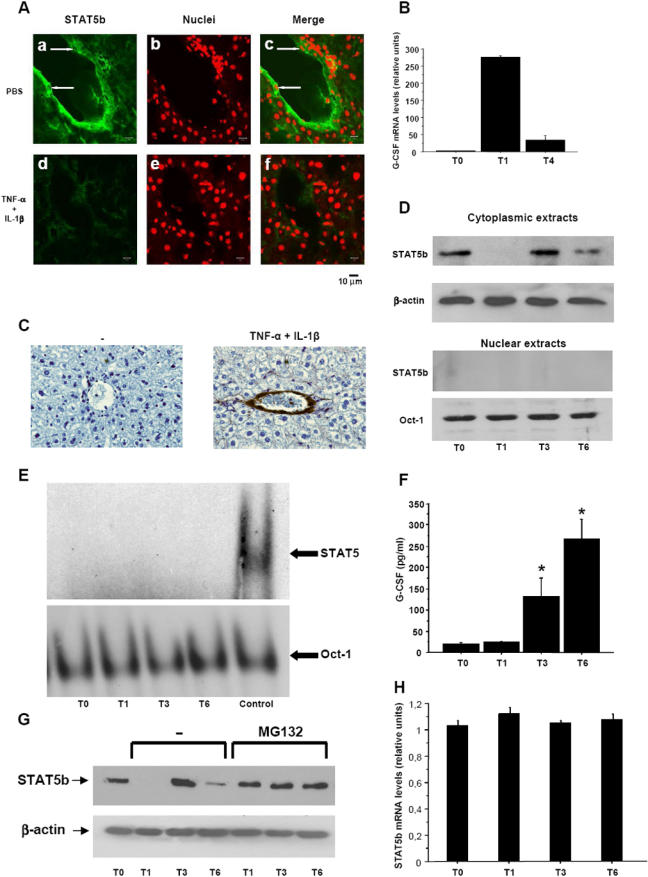
Degradation of cytoplasmic STAT5b in WT LECs following inflammatory stimulation, and subsequent enhancement of G-CSF production.(A) Wild-type mice were injected intravenously with PBS or with 2 µg recombinant murine TNF-α and 2 µg recombinant murine IL-1β. Livers were harvested 30 min later, and liver sections were analyzed for STAT5b expression and localization by immunofluorescence and confocal microscopy as described in the Experimental Procedures. (a) STAT5b was present in the cytoplasm (green), but not the nucleus (arrows), of LECs of PBS-treated mice. (d) STAT5b was no longer detectable in LECs of cytokine-treated mice. All cell nuclei in the fields are shown by hexidium iodide staining (red, b and e), and merges of frames (a) and (b), and (d) and (e), are given in (c) and (f), respectively. Bars = 10 µm. (B) Livers collected from cytokine-treated mice were assayed for G-CSF mRNA expression by quantitative RT-PCR. Livers were harvested before cytokine injection (T0), or either 1 (T1) or 4 (T4) hr postinjection. All values are normalized to β-actin mRNA. (C) Liver sections from untreated mice (left panel) and mice treated for 4 hr with TNF-α and IL-1β (right panel) were stained to visualize G-CSF (brown). Original magnification, 250×. (D) LSECs were isolated from wild-type mice and cultured for 3 days before experiments were performed. Cells were treated for 0 (T0), 1 (T1), 3 (T3) or 6 (T6) hr with 100 IU/ml TNF-α and 500 pg/ml IL-1β. Cytoplasmic and nuclear extracts were prepared and analyzed for STAT5b expression by immunoblot. Equal loading of proteins on the gel was confirmed by probing the blots for β-actin (cytoplasmic extracts) or Oct-1 (nuclear extracts). (E) Nuclear protein extracts were assessed for STAT5 DNA-binding activity by EMSAs. Binding of Oct-1 was used as an internal standard. Nuclear extracts from prolactin-stimulated bovine MAC-T cells were used as positive controls for STAT5 activation (control). (F) G-CSF concentrations in LSEC supernatants were measured by ELISAs. *, significantly different from T0 values with P<0.05. (G) LSECs were isolated from wild-type mice and cultured for 3 days before experiments were conducted. Cells were treated with 20 µM MG132 for 30 min prior to stimulation with 100 IU/ml TNF-α and 500 pg/ml IL-1β. Cytoplasmic extracts were prepared 0 (T0), 1 (T1), 3 (T3), and 6 (T6) hr later and analyzed for STAT5b expression by immunoblot. Equal loading of proteins on the gel was confirmed by probing the blots for β-actin. (H) LSECs stimulated for 0 (T0), 1 (T1), 3 (T3), and 6 (T6) hr with 100 IU/ml TNF-α and 500 pg/ml IL-1β were assayed for STAT5b mRNA expression by real-time quantitative RT-PCR. All values were normalized to β-actin mRNA.